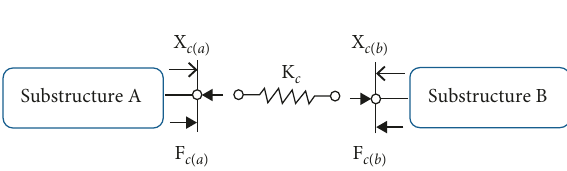
Figure 1: Dynamic model.